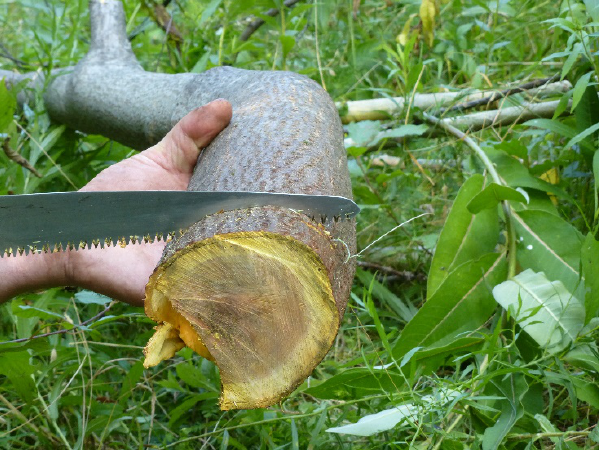
Figure 2. Harvested buckthorn stem cross section showing growth